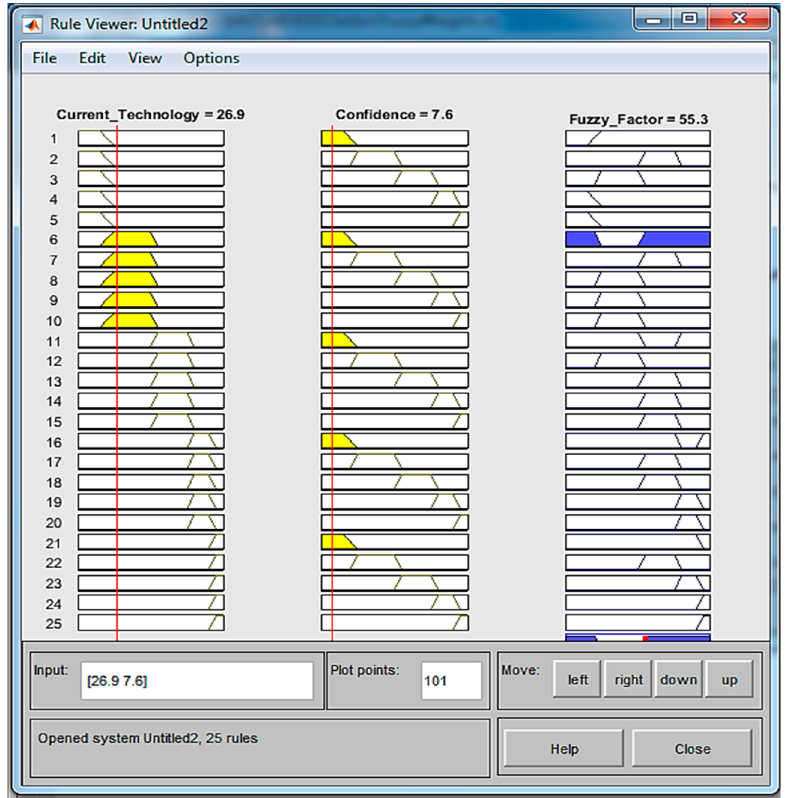
Figure 17. Fuzzy weight factor (group factor = 29.1; confidence = 7.6).